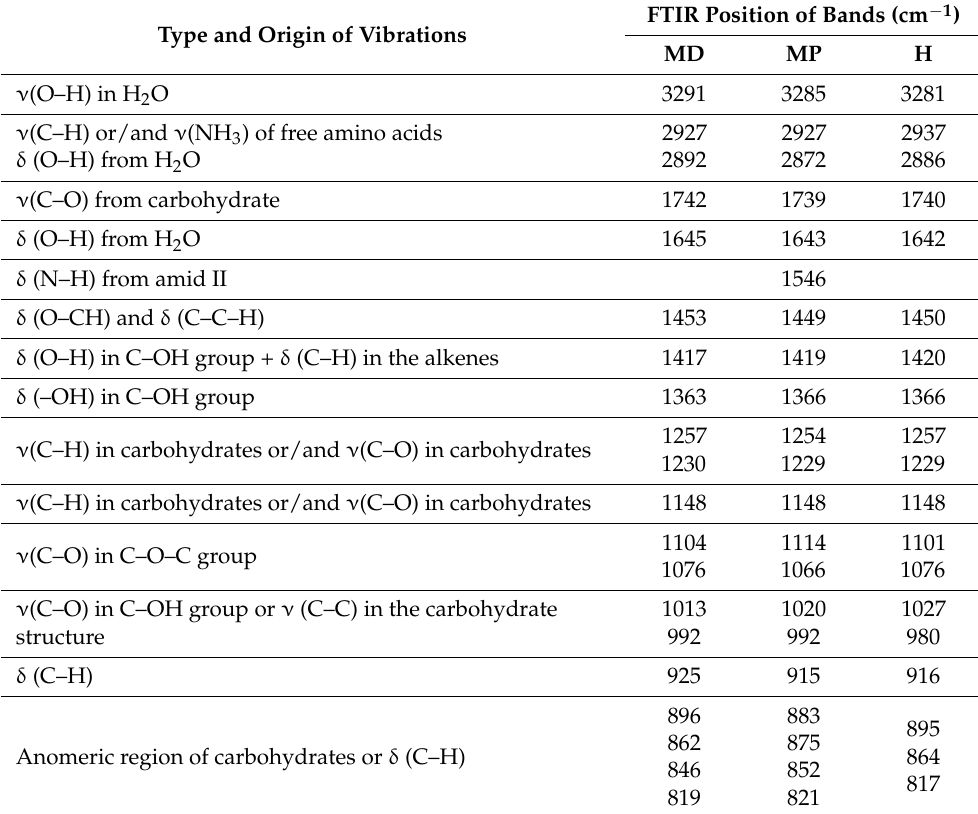
Table 2. The location of the maxima of absorption bands FTIR with arrangement of appropriate vibrations selected for maltodextrin (MD), skim milk powder (MP), and multifloral honey (H) made in terms of spectral 3900–700 cm − 1